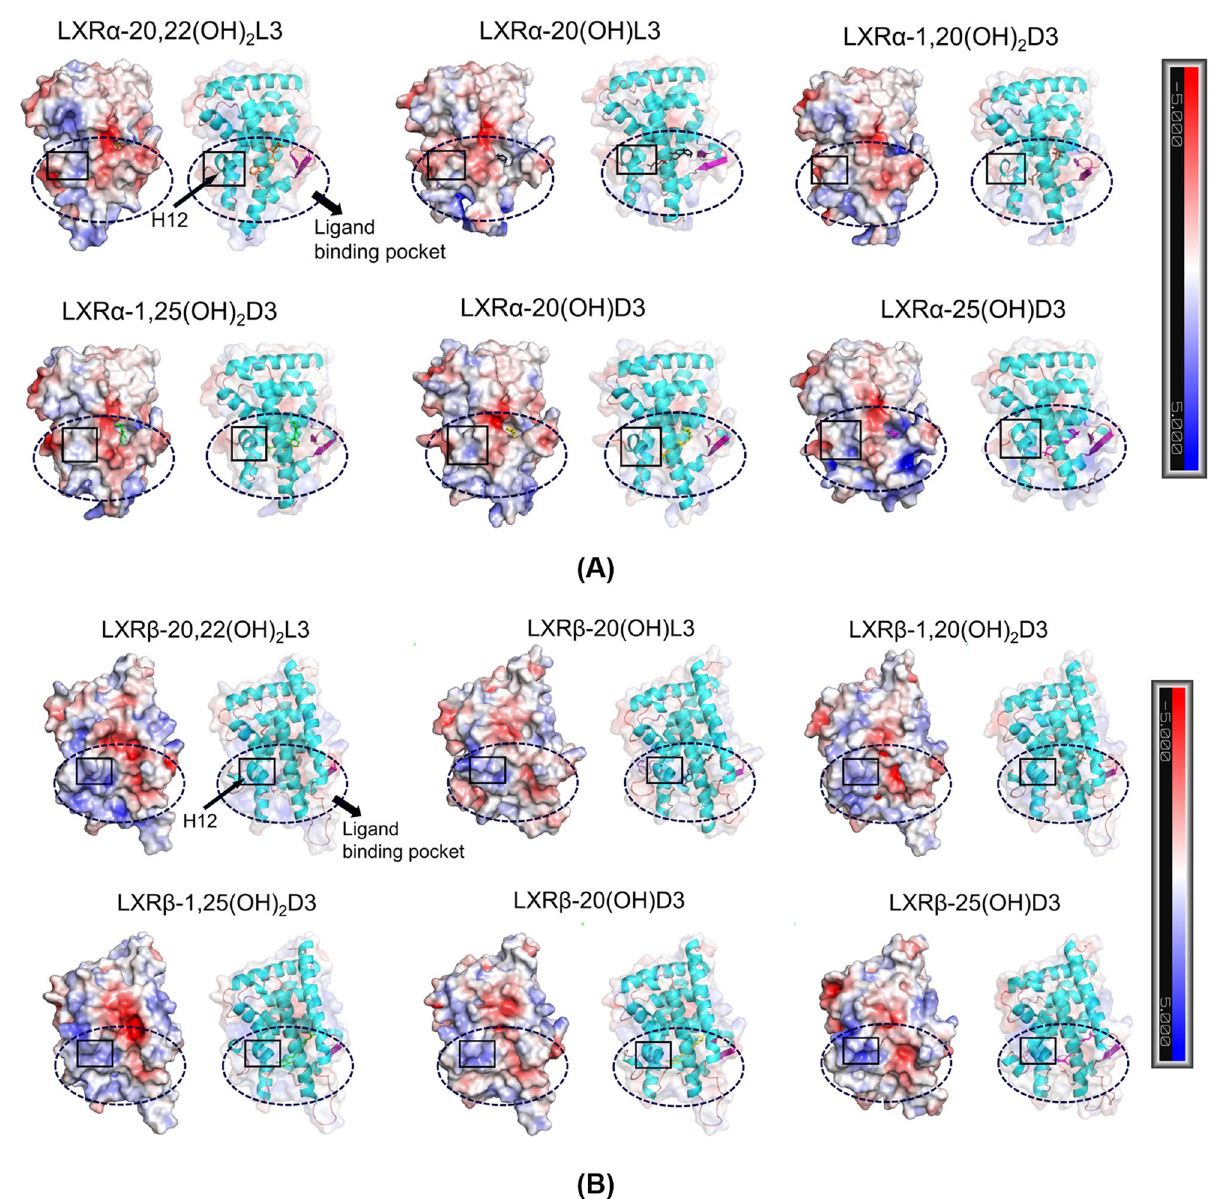
Figure 9. Varied electrostatic potential distribution for the LBD of LXRα ( A ) and LXRβ ( B ) bound with different D3 and L3 derivatives, including for the ligand binding pocket and H12 helix. Positive electrostatic potential is shown in blue and negative electrostatic potential is shown in red. The images were made with PyMOL(v2.4.0, https:// pymol. org/2/) 99 based on electrostatic potential analyses of the representative complex structures in our equilibrated MD simulations using APBS (v1.2.0, http:// www. poiss onbol tzmann. org/) 98